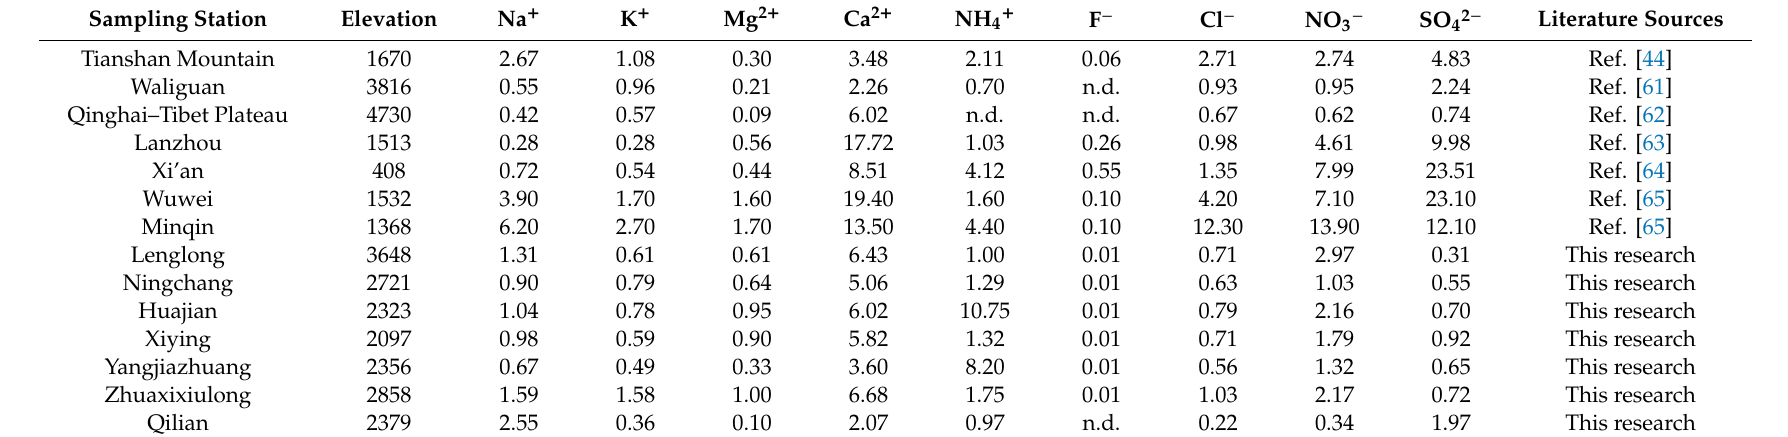
Table 8. Main ion concentrations of precipitation in this research and comparison with other